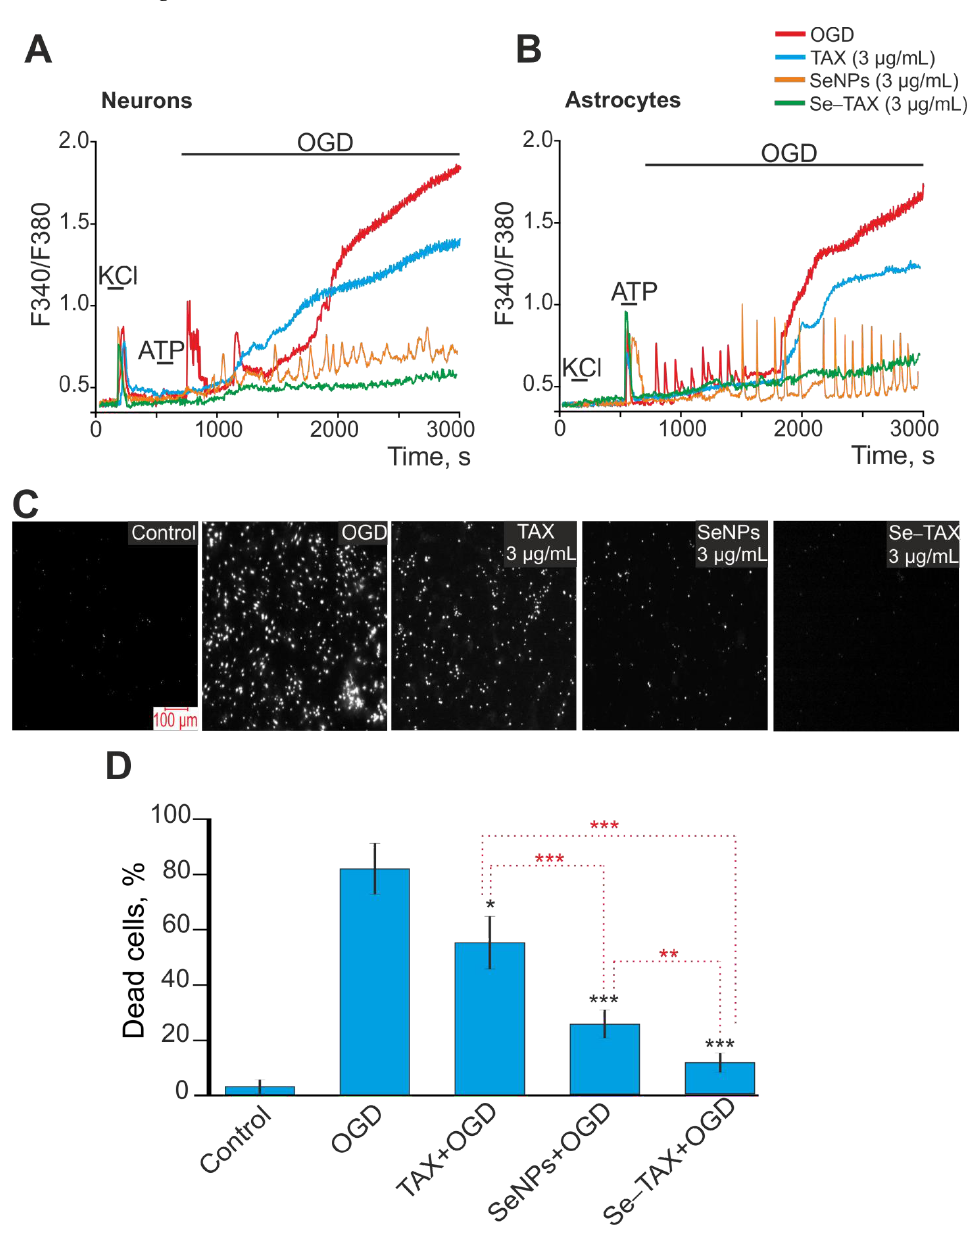
Figure 6. Effect of preincubation of cerebral cortex cells with TAX, SeNPs, or Se–TAX on Ca 2+ signal generation and survival after OGD. ( A , B ) Ca 2+ signals in neurons ( A ) and astrocytes ( B ) during OGD (40 min) and OGD after 24 h preincubation with 3 µ g/mL taxifolin, 3 µ g/mL SeNPs, or 3 µ g/mL Se–TAX. Short-term applications of 35 mM of KCl and 10 µ m of ATP were used to distinguish neurons and astrocytes, respectively. Ca 2+ signals from neurons and astrocytes averaged over several dozens of cells are presented. The experiments were performed in three replicates on three separate cell cultures. ( C ) Images of cortical cell culture loaded with propidium iodide (PI). The white dots represent the PI-stained nuclei of necrotic cells. ( D ) Effect of 24 h incubation with TAX, SeNPs, or Se–TAX on the cell viability after 40 min OGD. Black asterisks indicate the differences between the experimental groups compared with the OGD group. Differences between experimental groups are marked with red asterisks. *** p < 0.001, ** p < 0.01, and * p <